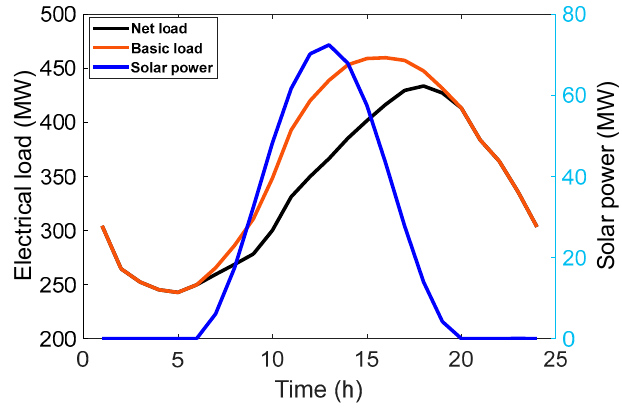
Figure 4. Basic load, net load and PV generation of the base case.